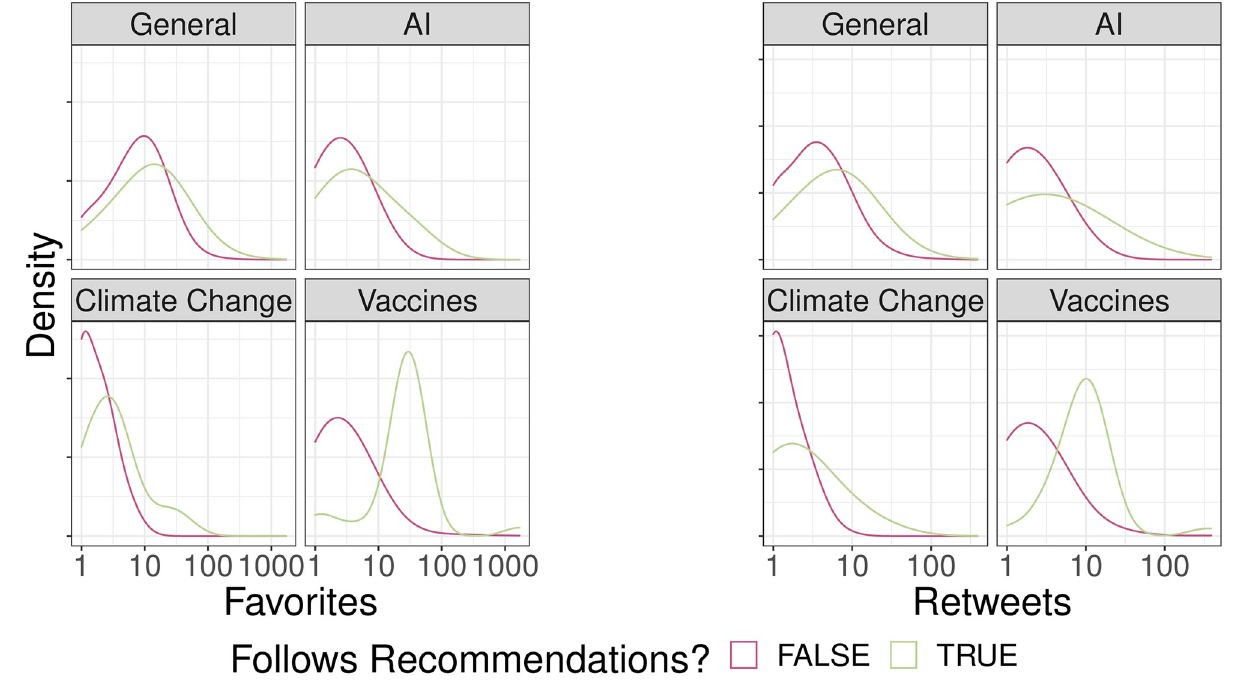
Fig 3. Distribution of reactions on Twitter. Kernel density estimates of Favourites (left) and Retweets (right) for each topic.